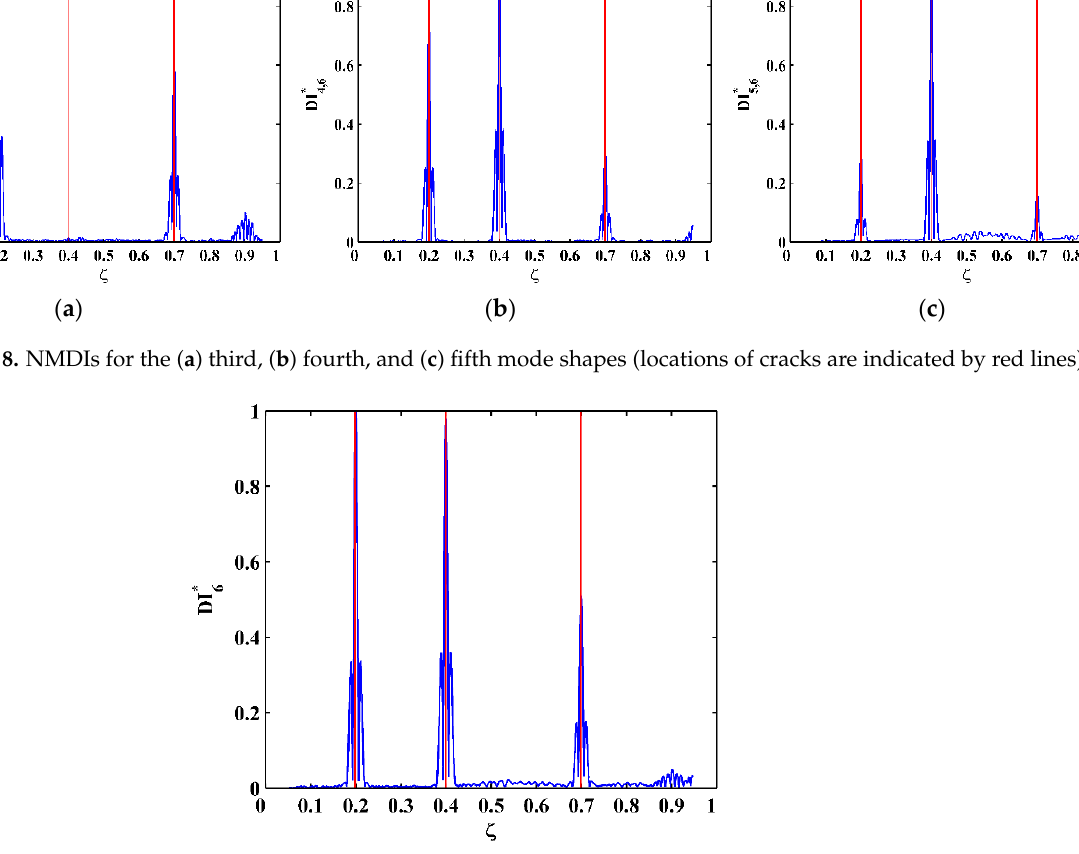
Figure 9. Fused NMDI for multiple crack identification (locations of cracks are indicated by red lines).